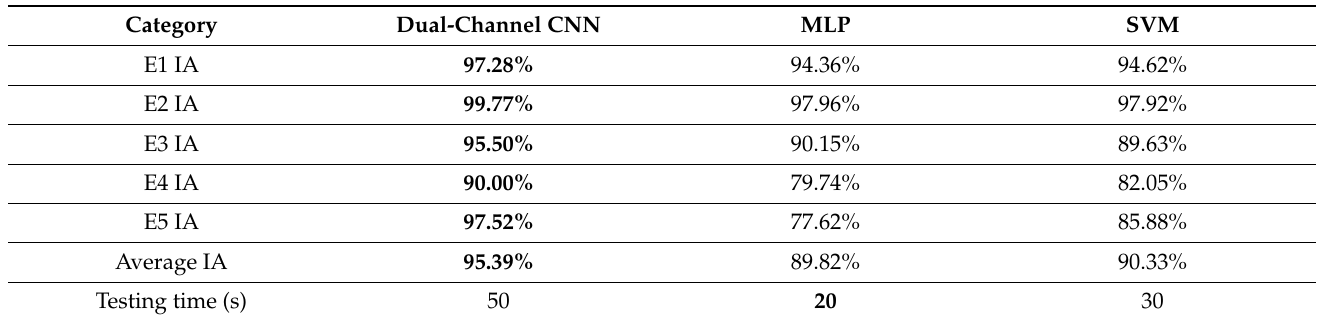
Table 9. Classification result of the dual-channel CNN, MLP, and SVM.